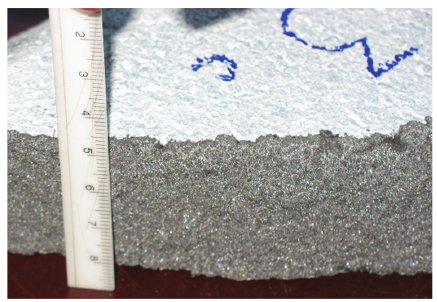
Figure 10: Macroaspect of the sample in zone B.